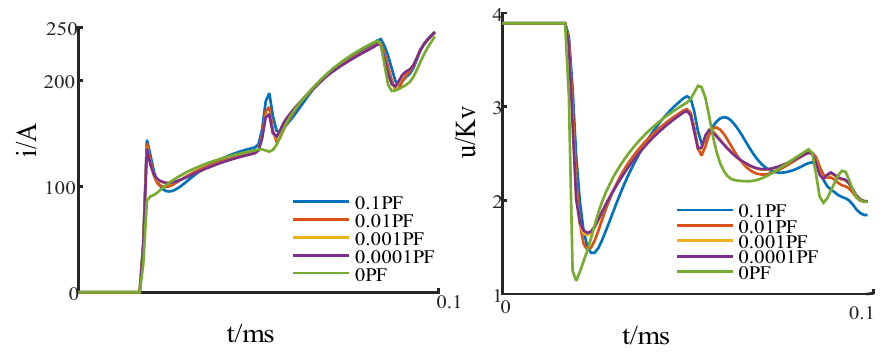
Figure 4. Influence of winding capacitance on traveling wave characteristics.